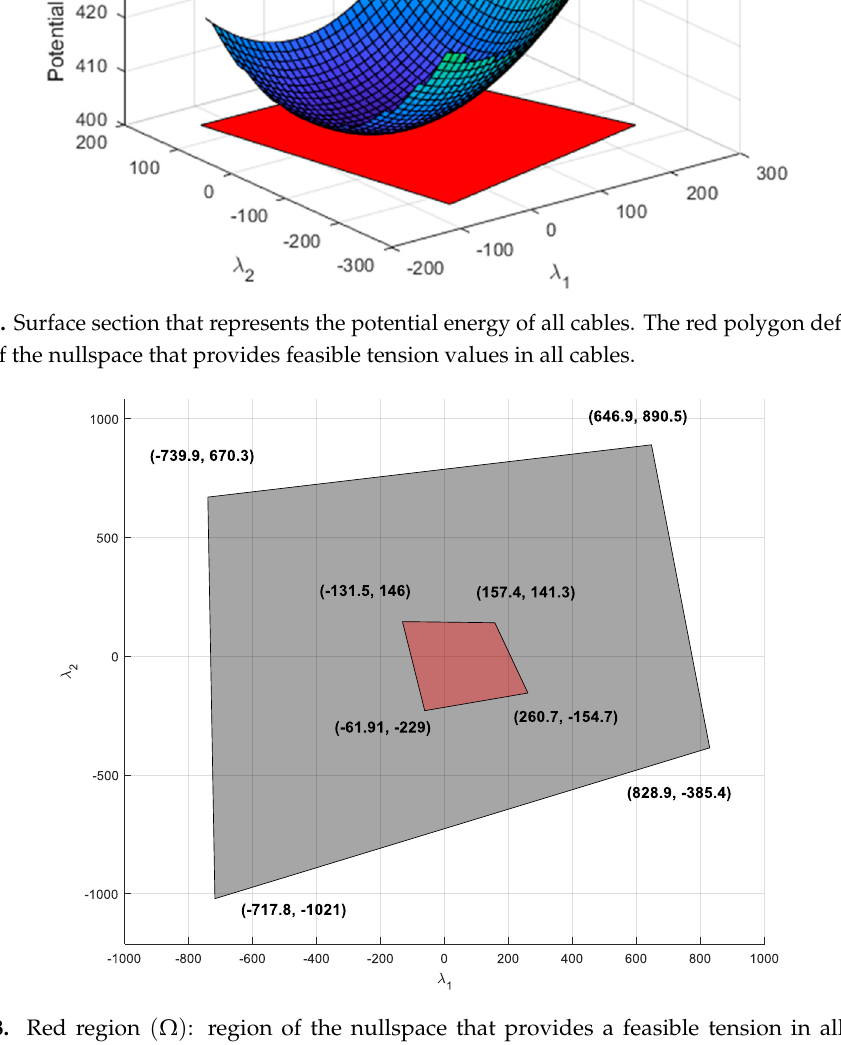
Figure 8. Red region ( Ω ) : region of the nullspace that provides a feasible tension in all cables. Black region (Ω ∗ ) : region of the nullspace that provides feasible efforts in all the rigid links of a parallel robot with the same configuration of the cable robot.